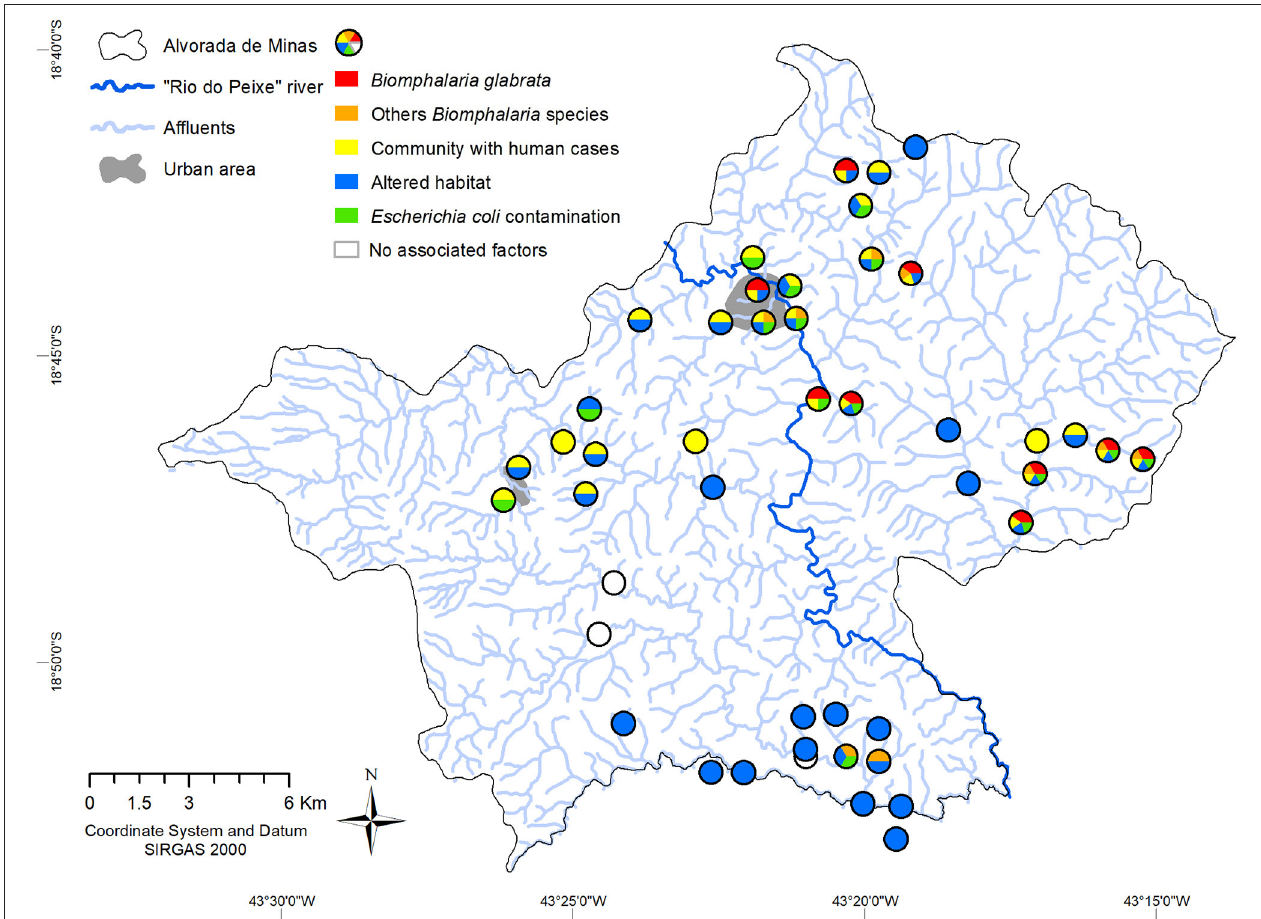
FIGURE 2 | Distribution of environmental and epidemiological data (malacology, altered environments and the presence of E. coli ), and cases of infected humans in the nearby communities, identified by collection points, in the municipality of Alvorada de Minas, Minas Gerais, Brazil. The white circles represent investigated areas that did not show factors associated with